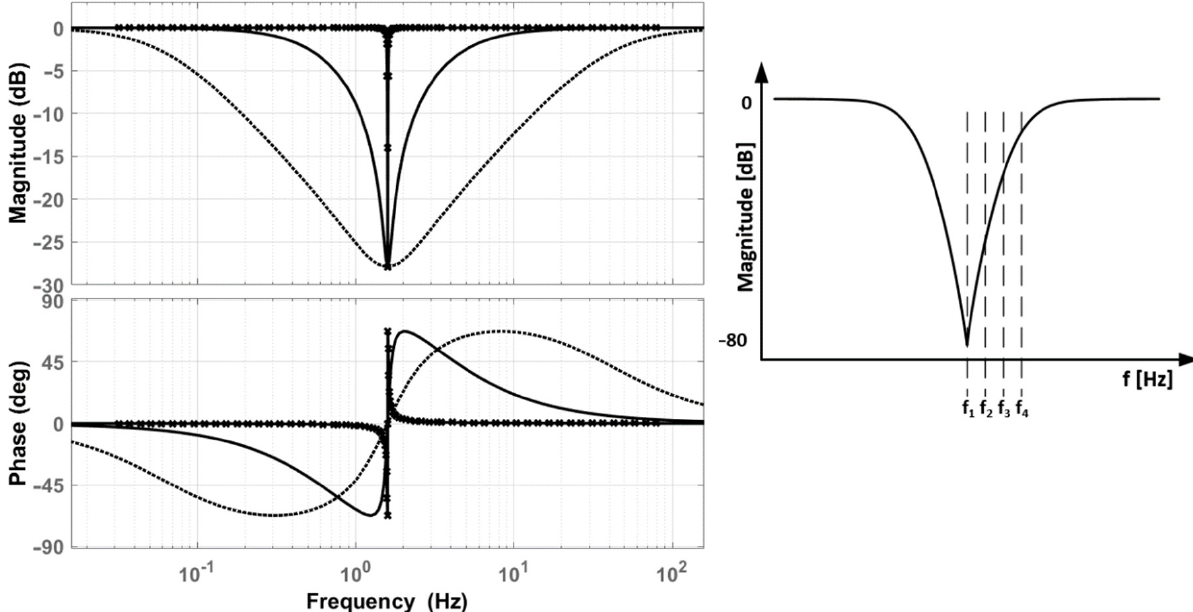
Figure 7. The Bode diagram of the notch filter ( left ), where ξ 1 and ξ 2 are multiplied by a factor a1 = 0.1, a2 = 1, and a3 = 10; Notch filter frequency curve ( right ) with frequencies: f 1 = 42 Hz, f 2 = 45 Hz, f 3 = 50 Hz, and f 4 = 55 Hz .